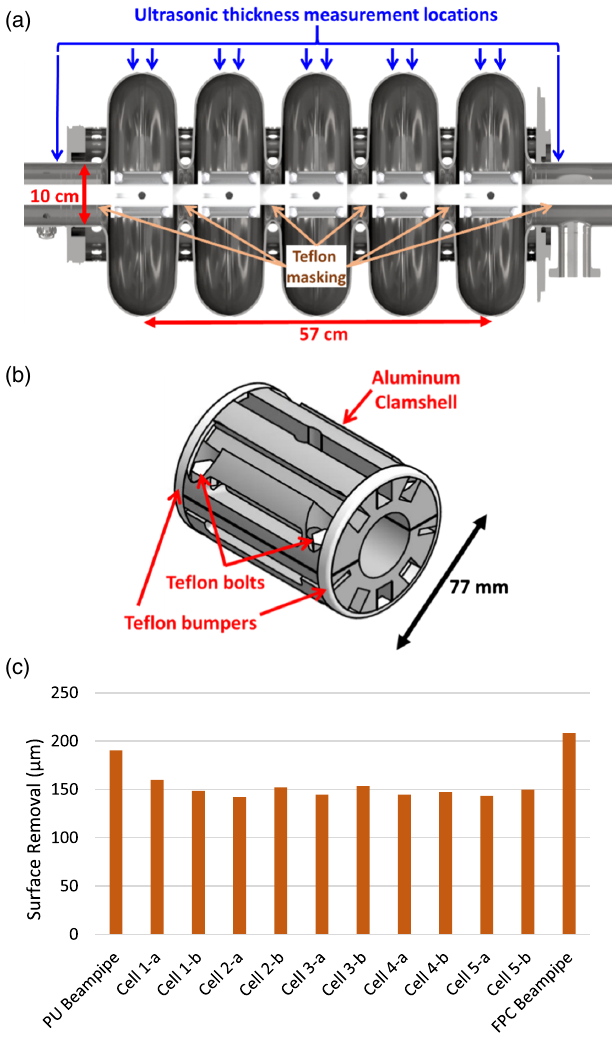
FIG. 1. S65-001 surface removal with bulk EP. (a) EP cathode integrated with the cavity. This also shows the doughnuts on the cathode at the equator locations and Teflon shielding at the iris locations. Red arrows indicate the locations for ultrasonic thick- ness measurements. (b) “ Doughnut ” to increase the cathode radius at the equator locations. Five doughnuts are attached to a cylindrical aluminum tube with 34 mm diameter; the remaining area of the aluminum tube is masked by Teflon tape. (c) Surface removal at the locations of the beampipes and equators. Since the outer surfaces of the irises were not easy to access due to stiffening rings, we measured the beampipes as a representation of the surfaces at a small radius. PU and FPC denote the pickup and fundamental power coupler,